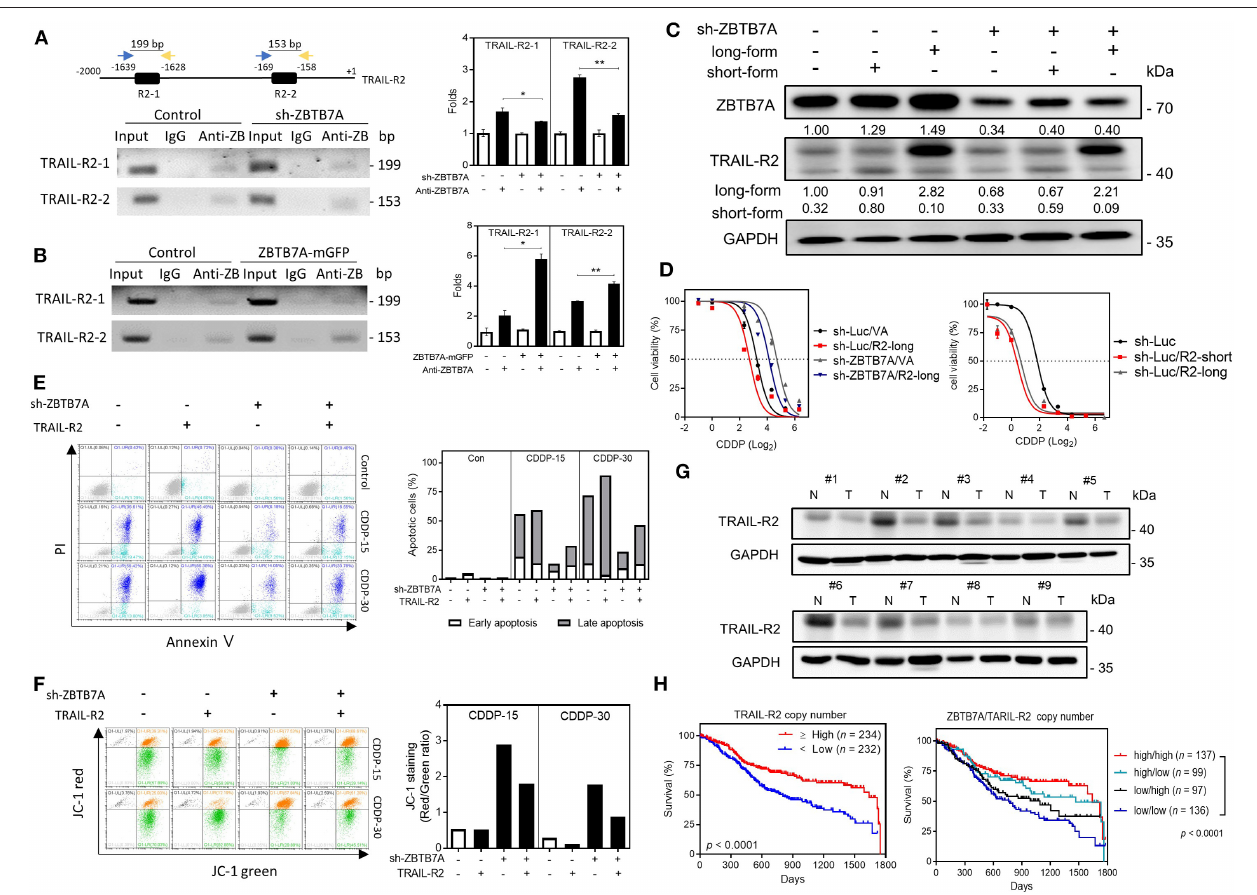
FIGURE 5 | ZBTB7A sensitizes SAS cells to CDDP by trans-activation TRAIL-R2. (A) Lt Upper, schematic diagram depicting the ChIP strategy. R2-1 and R2-2 are predicted to be ZBTB7A binding sites in the TRAIL-R2 promoter. ( A , Lt Lower; B , Lt) Representative gel electrophoresis images of the PCR analysis; these reveal the amplicons of R2-1 and R2-2 sequences using the various immunoprecipitates, namely control, ZBTB7A knockdown and ZBTB7A exogenous expression cells. ( A,B , Rt), quantification. The analysis indicates that ZBTB7A expression increases, and ZBTB7A knockdown decreases the binding of the ZBTB7A to TRAIL-R2-1 and TRAIL-R2-2 sites, respectively. Anti-Z: anti-ZBTB7A antibody. (C,D) Long-form and short-form TRAIL-R2 expression, respectively. Lt, Western blot analysis confirming the expression of TRAIL-R2 in the SAS ZBTB7A knockdown cell subclone by means of TRAIL-R2 retroviral infection. Rt, CDDP sensitivity as related to expression of ZBTB7A and TRAIL-R2. (E) Apoptosis assay. Lt, flow cytometry diagram. Rt, quantification. The CDDP-induced apoptosis is decreased by ZBTB7A knockdown and this is reversed by TRAIL-R2 expression. (F) Lt, Mitochondrial membrane potential analysis. Rt, Quantification of the red/green ratio. Following 15 or 30 µ M CDDP